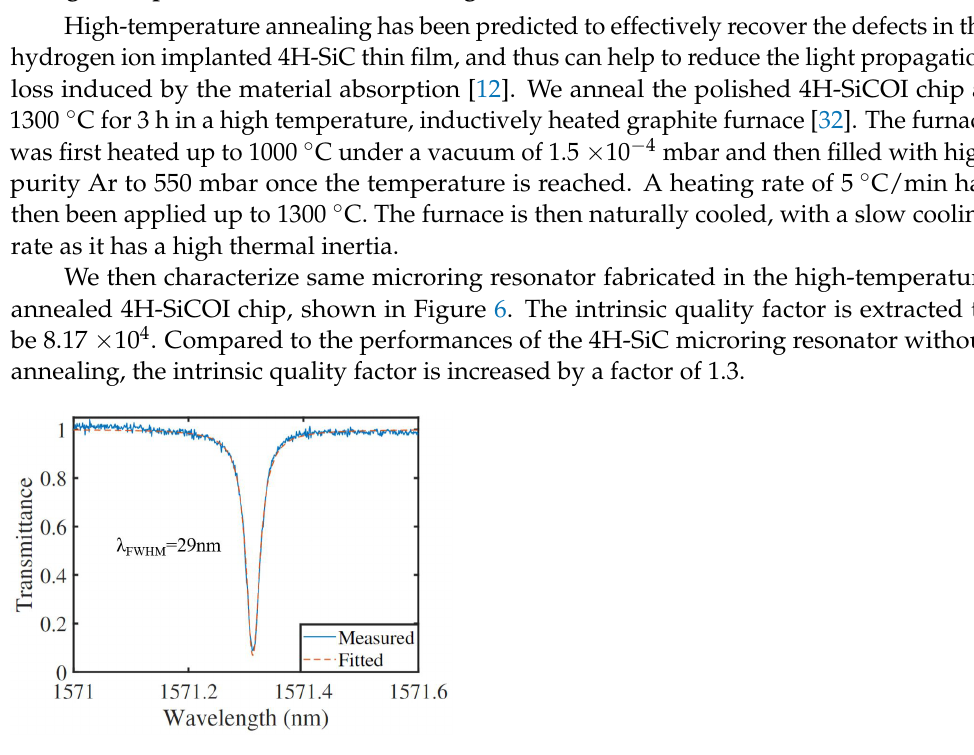
Figure 6. Transmittance of the optical microring resonators after high temperature